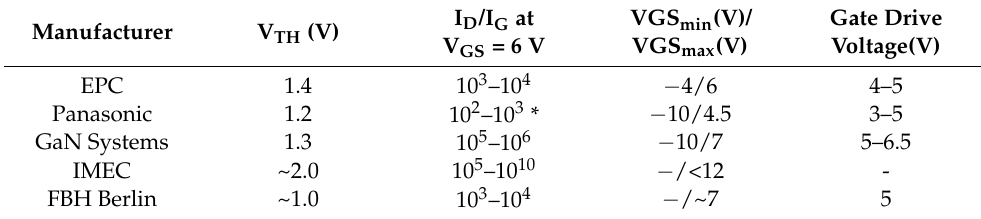
Figure 19. ( a ) Cross-sectional schematic of p-GaN gate HEMT [102] and ( b ) schematic of the operation principle of the normally on HEMT and ( c ) normally off HEMT [99]. (Data from [99,102]). Table 2. Gate characteristic of different p-GaN devices [102] .